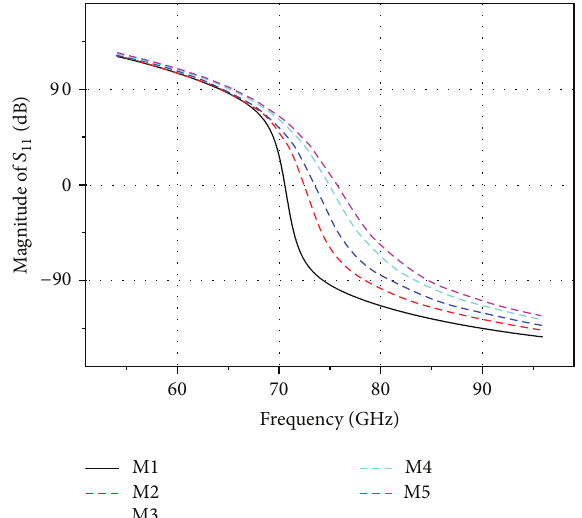
Figure 9: Variations of 𝑆 11 phase when the AMC is constructed in CMOS different metal layers (from M1 to